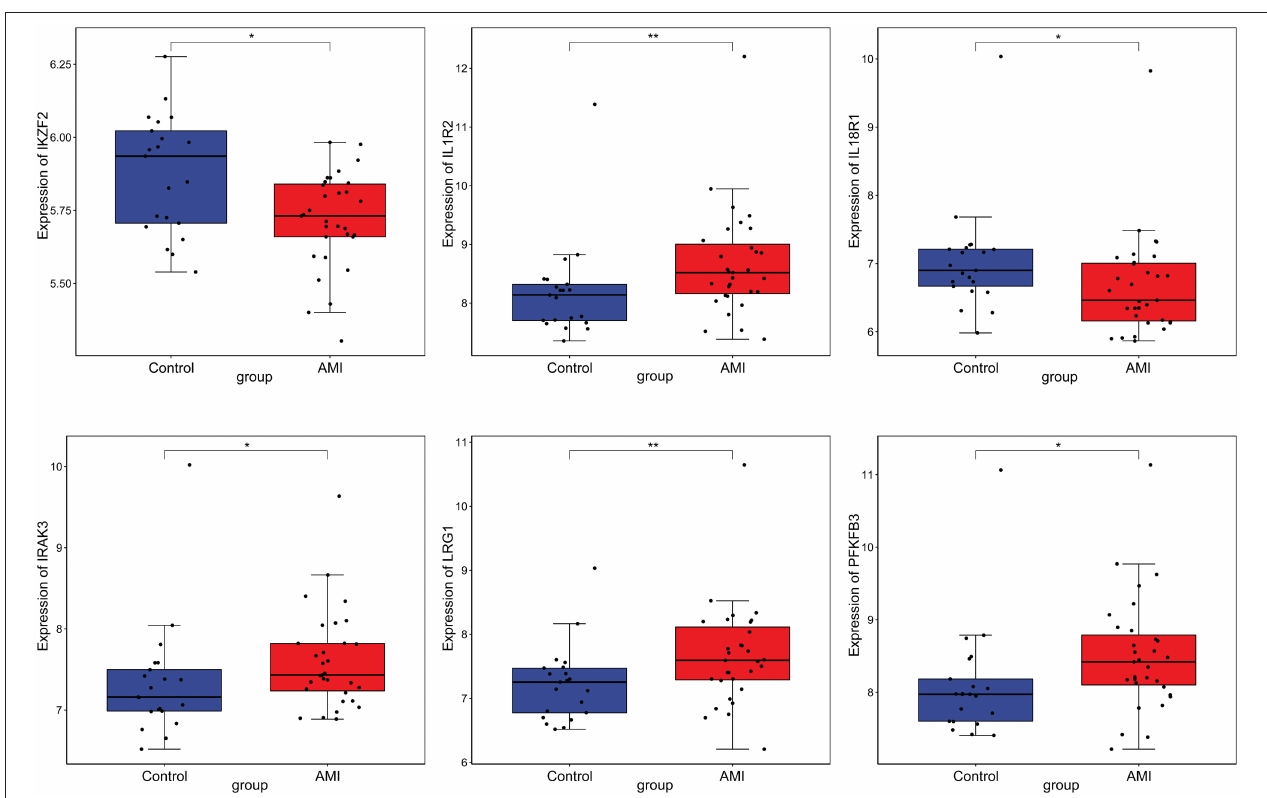
FIGURE 8 | The box plot of IKZF2, IL1R2, IL18R1, IRAK3, LRG1, and PFKFB3 in GSE48060 of the AMI dataset. * p < 0.05; ** p <